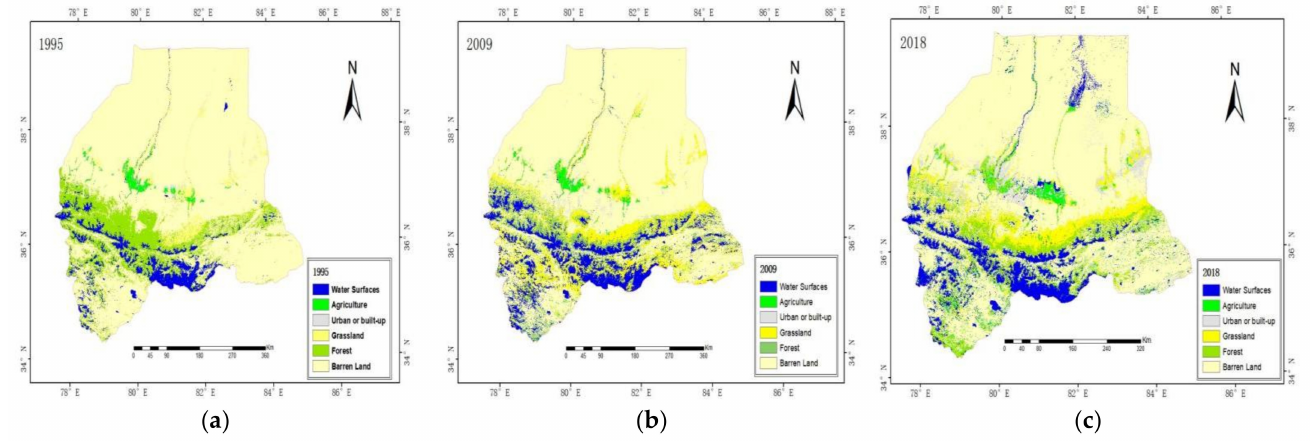
Figure 2. Results of land use classification in Hetian: ( a ) 1995; ( b ) 2009; ( c ) 2018.